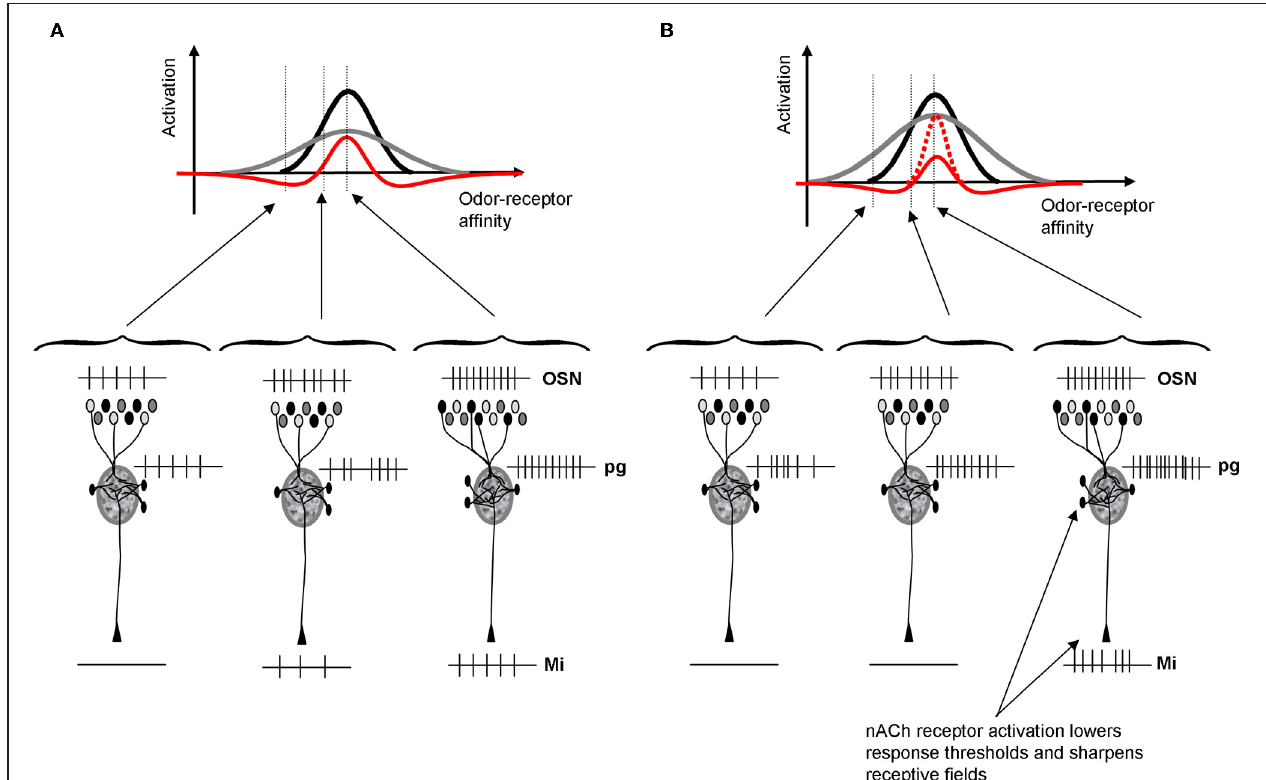
FIGURE 2 | Schematic depiction of cholinergic modulation of glomerular contrast enhancement. (A) Within OB glomeruli, mitral and PG cells receive direct inputs from OSNs. PG cells have a higher input resistance and hence respond more quickly and saturate earlier than mitral cells. As a consequence, PG cells inhibit mitral cells in response to low affinity odorants but mitral cells override this inhibition in response to high affinity odorants. This microcircuit leads to contrast enhancement within each glomerulus, independent of location and receptive field (Cleland and Sethupathy, 2006; Cleland and Linster, 2012). The graph shows mitral (black) and PG (gray) cell activation levels as a function of varying the odor affinity between the receptor expressed in OSNs projecting to that glomerulus. PG cells inhibit